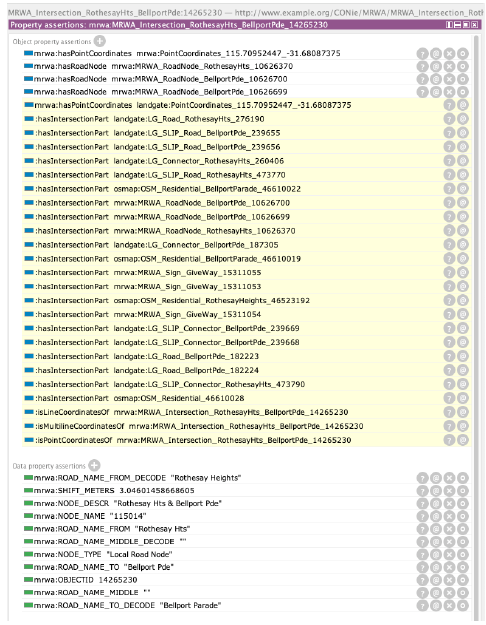
Figure 11. Result of the shifted MRWA road network. The result of the shifting algorithm of MRWA intersections to Landgate SLIP data road nodes for the selected road network